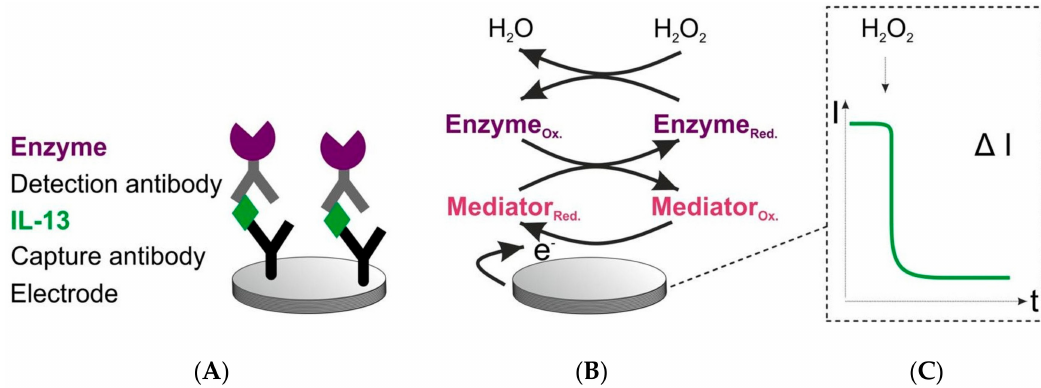
Figure 1. Scheme of sensor set-up and signal generation. ( A ) Sensor set-up. Capture antibodies are covalently immobilized on a single-walled carbon nanotube (SWCNT) working electrode. Detection antibodies are biotinylated. The enzyme (violet) used for read-out is a streptavidin–horseradish peroxidase (HRP) conjugate. ( B ) Signal generation of the sensor. Reaction is initiated by adding hydrogen peroxide. Ox. = oxidized form. Red. = reduced form. Mediator (red.) = hydroquinone, mediator (ox.) = quinone. ( C ) Recorded signal. Change in current over time, when hydrogen peroxide is